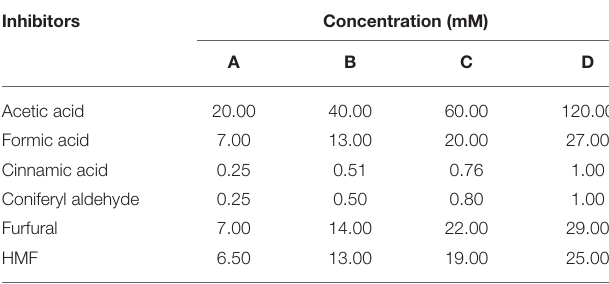
TABLE 1 | Inhibitor mixtures used in this